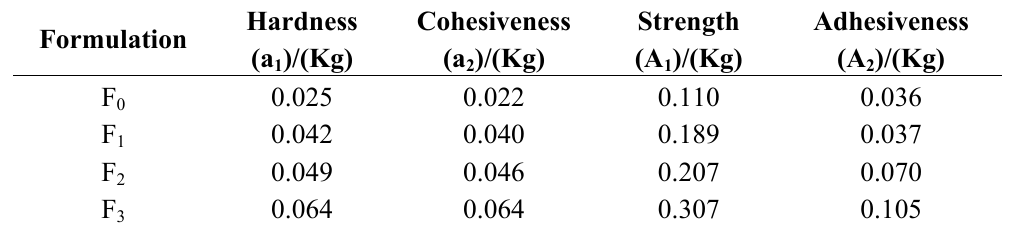
Table 2. The effect of NB/HP- β -CD concentration on mechanical properties of thermosensitive composite hydrogel.